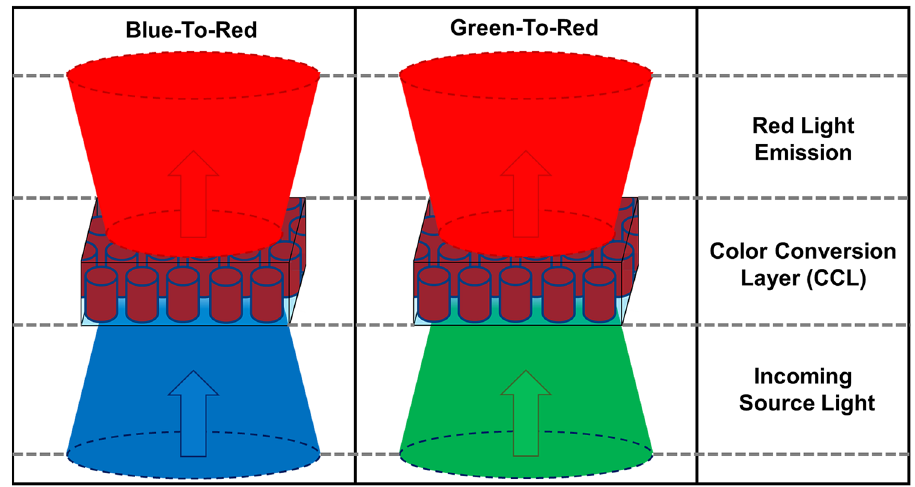
Figure 1. Schematics depicting the color conversion from blue-to-red and green-to-red based on (optimized) GaInP nanowire arrays embedded in a transparent film (color conversion layer